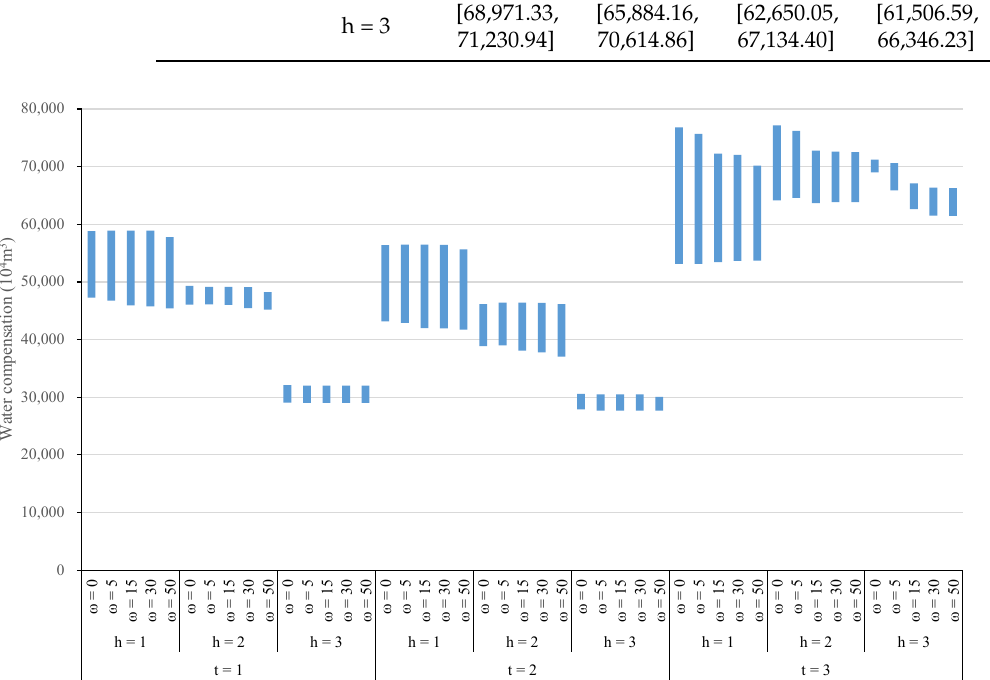
Figure 4. Water compensation for the Fenhe River Basin.